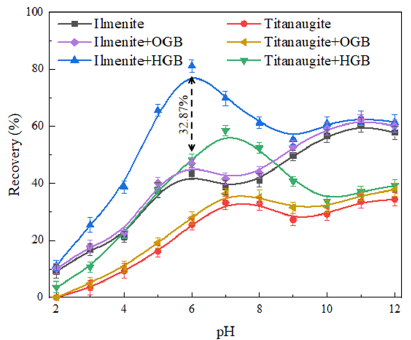
Figure 6. Effect of pH on flotation recovery of NaOL adsorbed fine ilmenite and fine titanaugite in the absence and presence of HGB and OGB (the mineral size distributions of 0–19 µm, 4.0 × 10 −4 mol·L –1 sodium oleate, HGB/OGB dosage = 0.02 g).